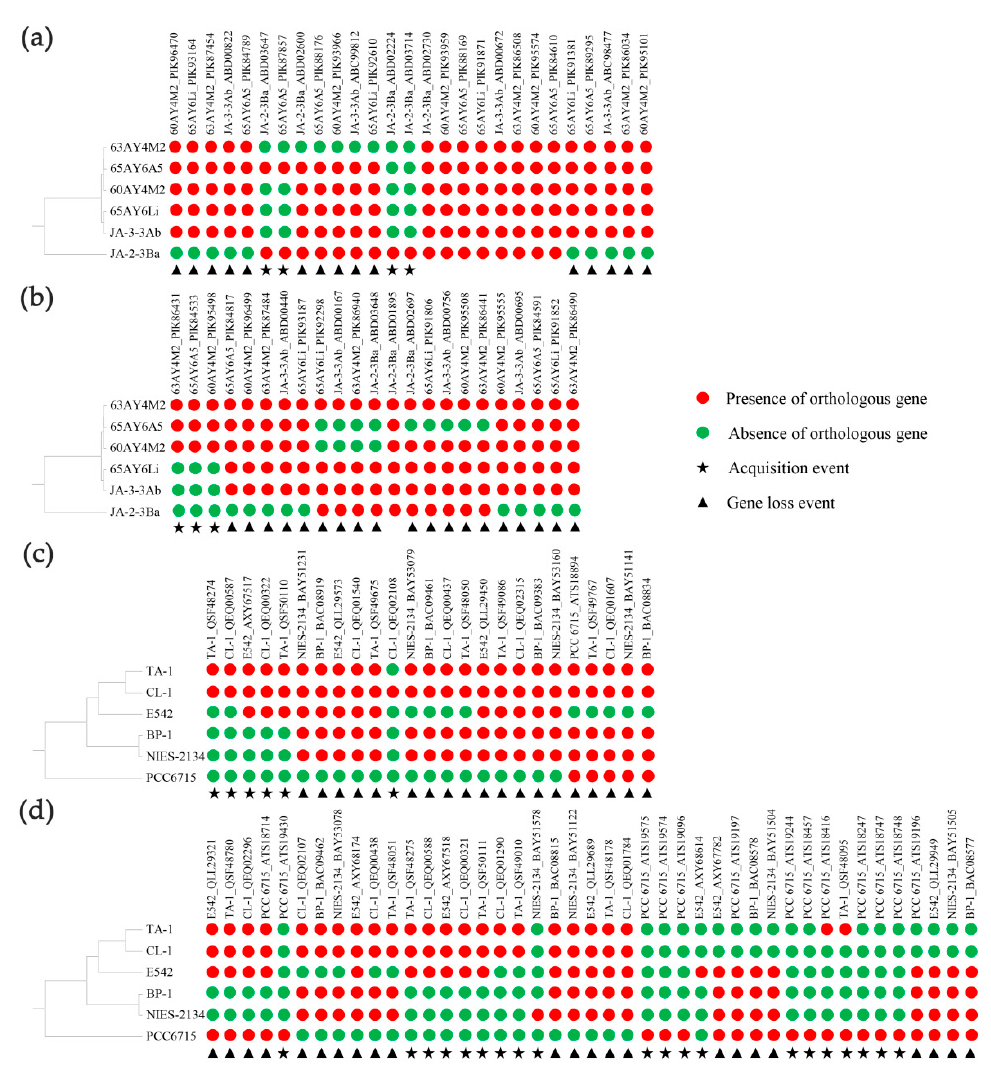
Figure 4. Occurrence of accessory TCS genes in Thermostichus ( a : HKs, b : RRs) and Thermosynecho- coccus strains ( c : HKs; d : RRs). The UPGMA trees on the left were built based on ANI distances of focal genomes. The HKs and RRs were named by the strain name plus accession number and shown in order of appearance in the respective phylograms (Figures S1 and